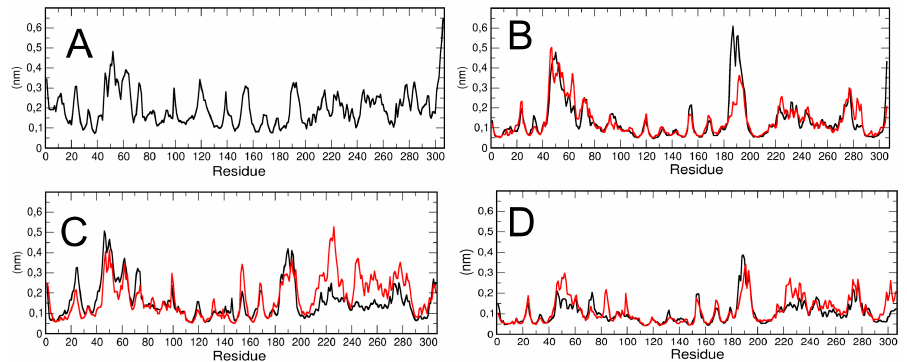
Figure 3. Comparison between the structural flexibility of 3CLpro monomeric and dimeric form.